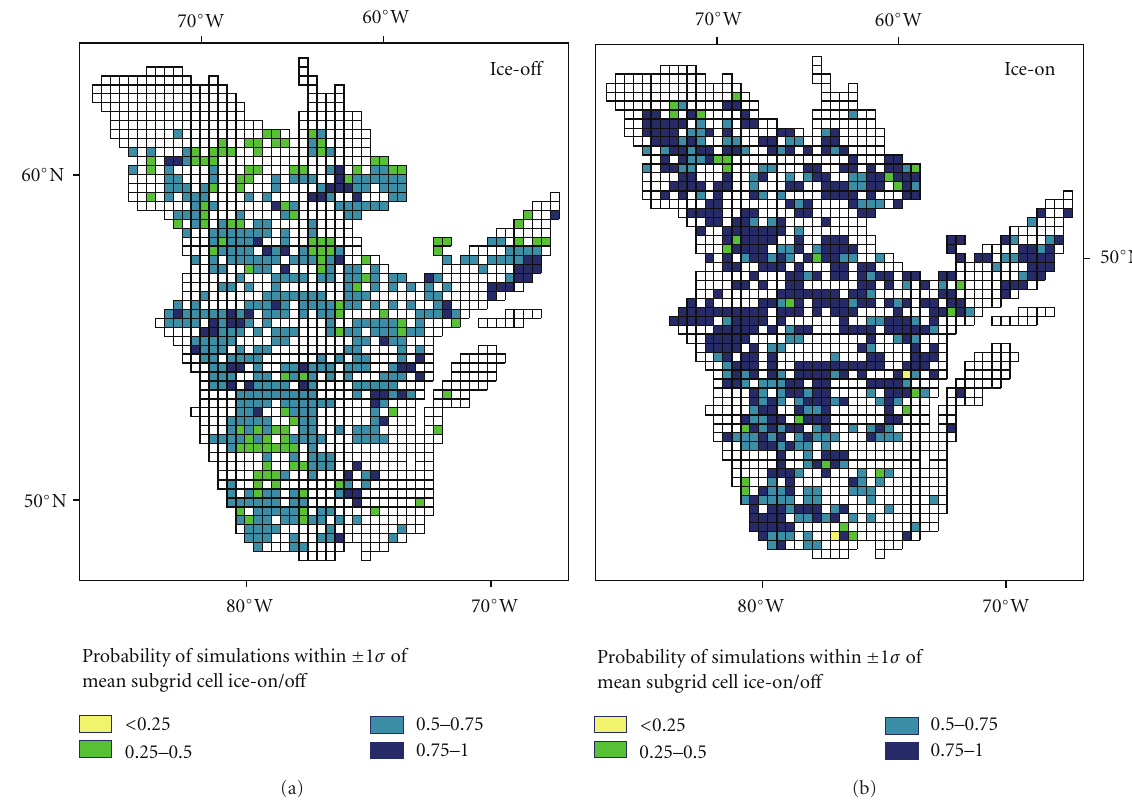
Figure 10: Probability of the simulations from 2000 to 2010 being within ± 1 standard deviations of the mean satellite-detected ice-on/o ff dates for each grid cell. Empty grid cells corresponded to areas where either no lakes were identified using the filtered MODIS product or no probabilities were determined due to an incomplete data record (only grid cells with a complete 11-year satellite record were